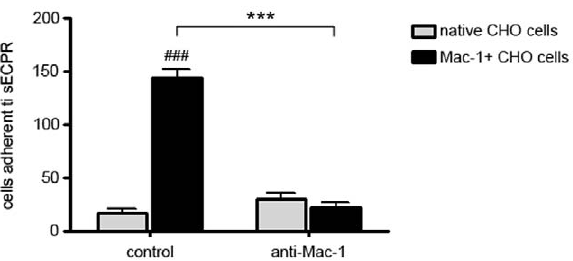
Figure 3. Specific binding of CHO cells expressing activated Mac-1 to recombinant EPCR in static adhesion assay. Specific binding of CHO cells transfected with permanently activated Mac-1 (Mac-1 + CHO cells; black bars) to soluble, recombinant EPCR in a static adhesion assay (left). Blocking with an anti-Mac-1 antibody resulted in loss of EPCR binding capacity of Mac-1 + CHO cells (right). Native CHO cells without transfection of Mac-1 served as a negative control (light grey bars). ( ### p , 0.0005; ns = statistically not significant vs.native CHO cells; *** p ,